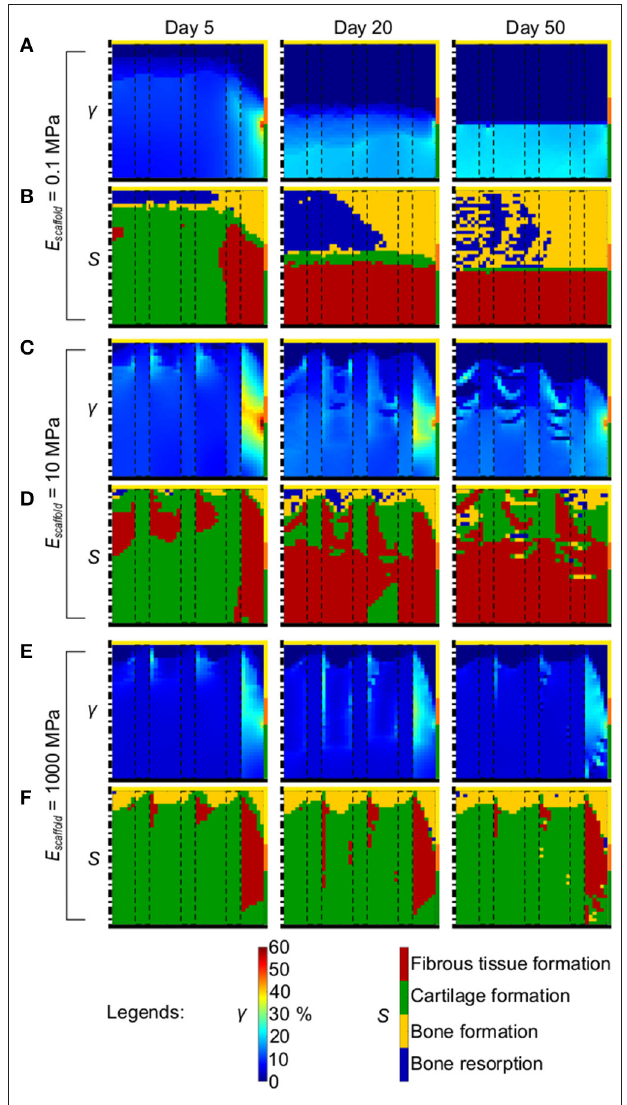
FIGURE 6 | Mechanical environment in the osteochondral defect in dependency of the elastic modulus of the scaffold material. (A,C,E) Distribution of γ with scaffold material having 0.1, 10, and 1,000 MPa elastic modulus, respectively; (B,D,F) prediction of tissue formation based on S with scaffold material having 0.1, 10, and 1,000 MPa elastic modulus, respectively. Left, middle, and right columns show results at day 5, 20, and 50, respectively. The scale bars to interpret the plots are on the bottom. The black dash-dot lines and the black solid lines mark the axis of symmetry and the articular interface, respectively. The colors of the borders indicate the neighboring tissues in the FE model of the femoral condyle: yellow, orange, and green stand for cancellous bone, subchondral bone, and cartilage, respectively. The black dashed rectangles mark the struts of the